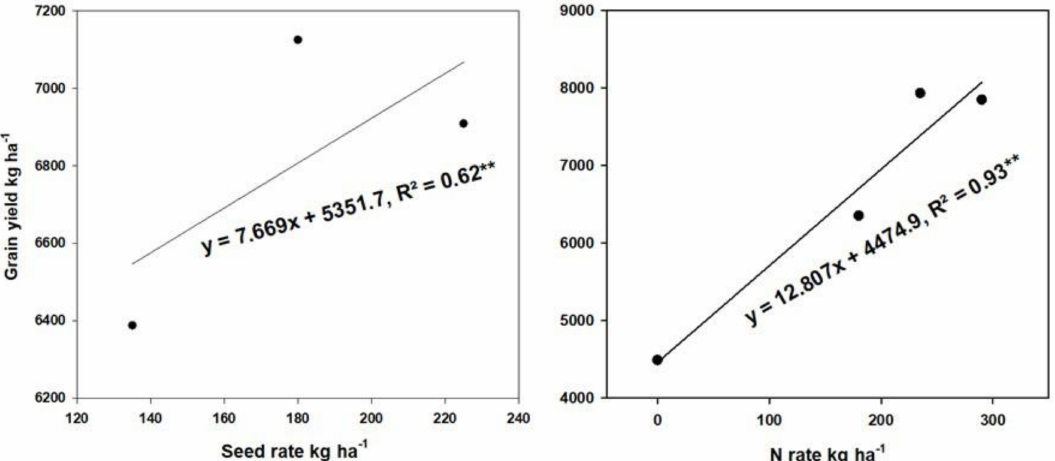
Figure 5. Estimating the regression line to compare N and seed rate for balancing grain yield and improving NU E . * p ≤ 0.05 and ** p ≤ 0.001, respectively. The dots represent the mean value of grain yield under each seed rate (left) or nitrogen rate (right).